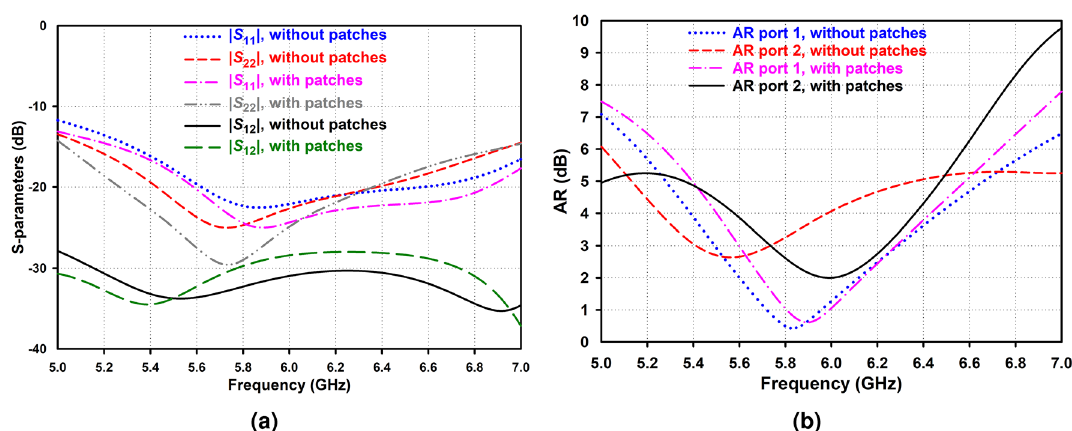
Figure 8. Simulated ( a ) S-parameters and ( b ) AR of the proposed antenna with and without the metal